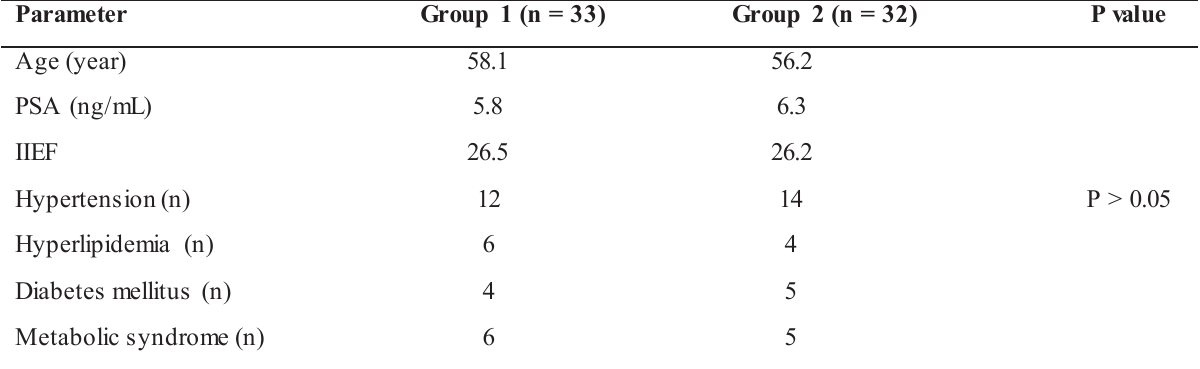
Tadalafil therapy after BNSRRP Table1 - Preoperative data of both Table 1 - Preoperative data of both groups.